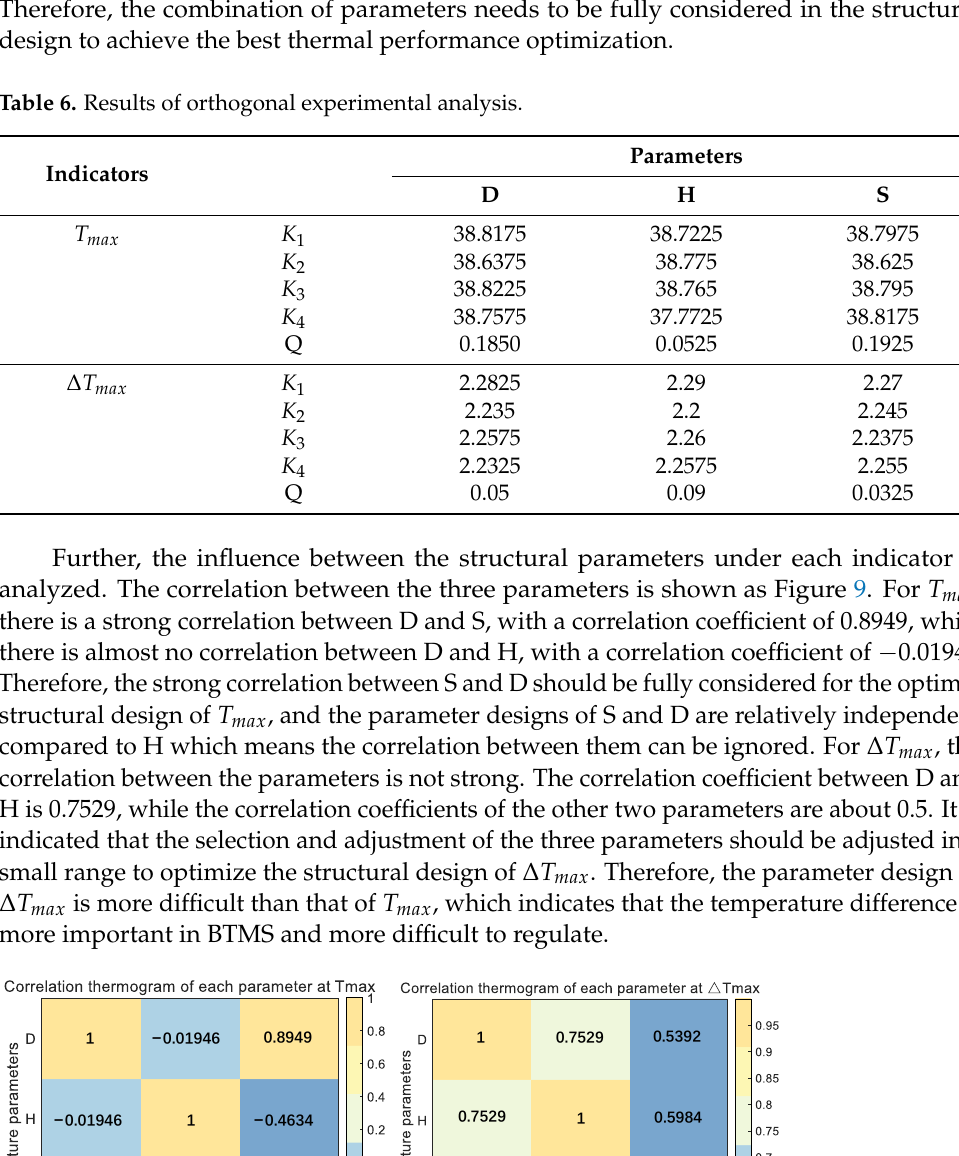
Figure 9 . Thermal diagram of the correlation of each parameter at 𝑇 𝑚𝑎𝑥 and Δ 𝑇 𝑚𝑎𝑥 . Figure 9. Thermal diagram of the correlation of each parameter at T